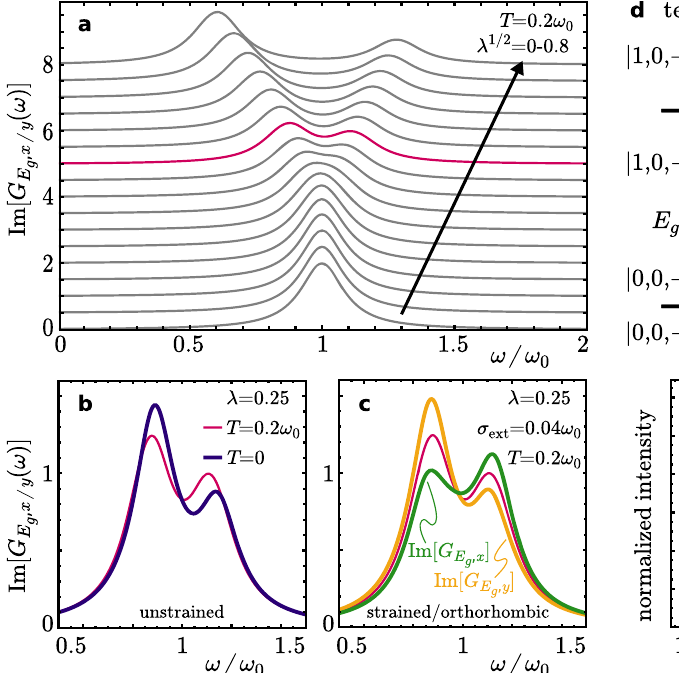
Fig. 4 | Model calculation. a Calculation of the E g Raman response using a simple model of two degenerate harmonic oscillators coupled via λ to a fl uctuating nematic degree of freedom. Details of the calculation are laid out in the Supple- mentary Note 4. Parameters for the B 1g fl uctuation frequency and temperature are chosen Ω = ω 0 /20, T = ω 0 /5. b Theweightdistributionofthepeaksplittingdepends on the relative energy scales in the problem, as illustrated for two different tem- peratures T ≪ Ω and Ω ≪ T ≪ ω 0 . c In the disordered case with equal peak splitting